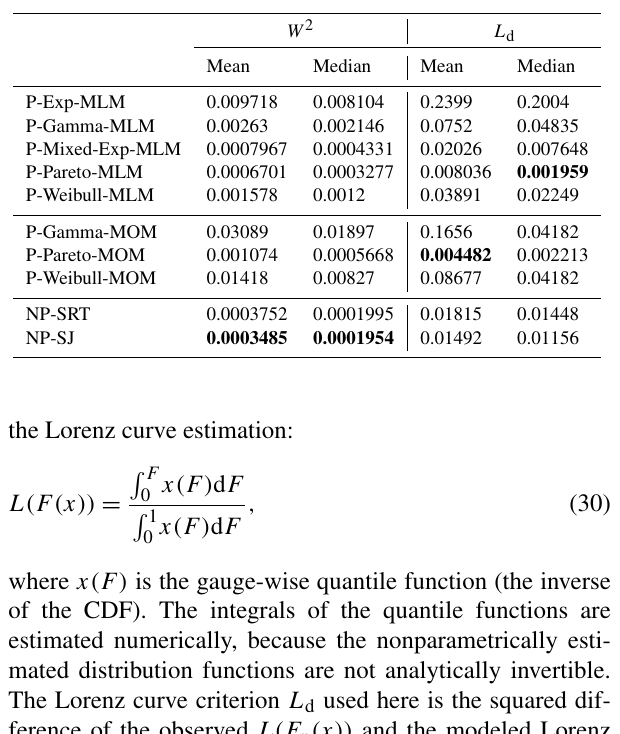
Table 3. The mean and median of the two quality measures W 2 and L d for the 10 precipitation amount models over the study region for hourly values (1h) in the winter season. The bold numbers indicate the lowest (best) value of the corresponding